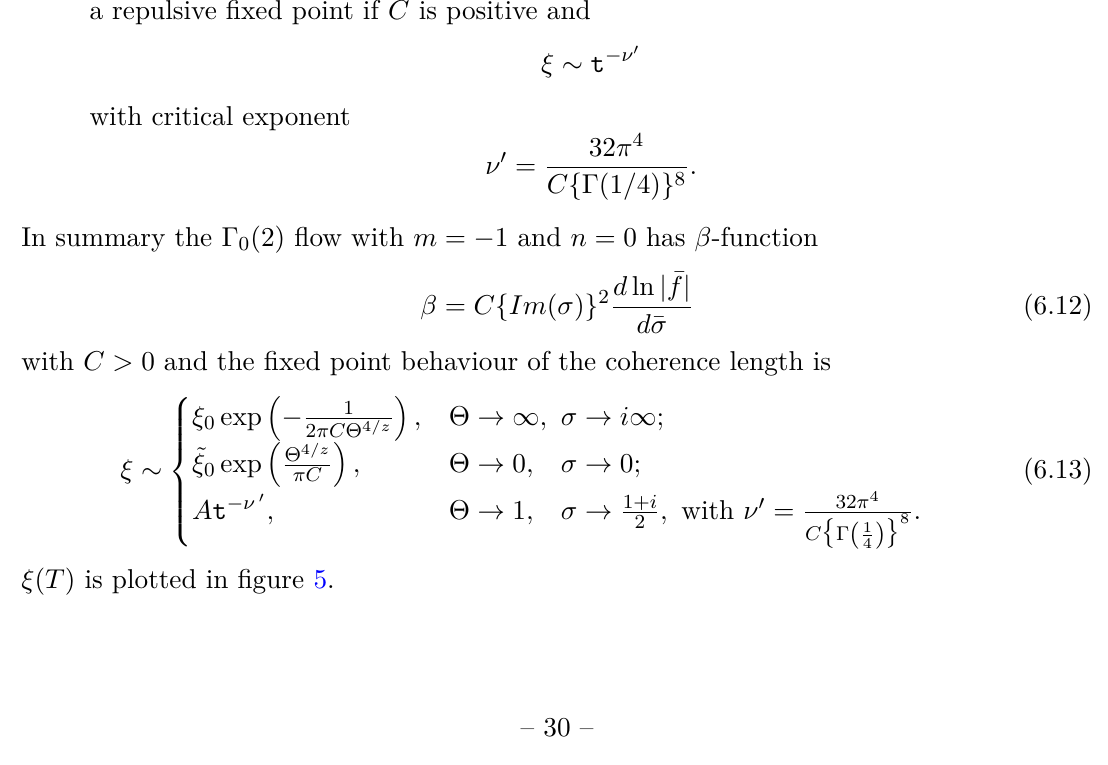
JHEP08(2021)010 = C = 1 , which numerically is ξ 1 . 540 . 0 0 ≈